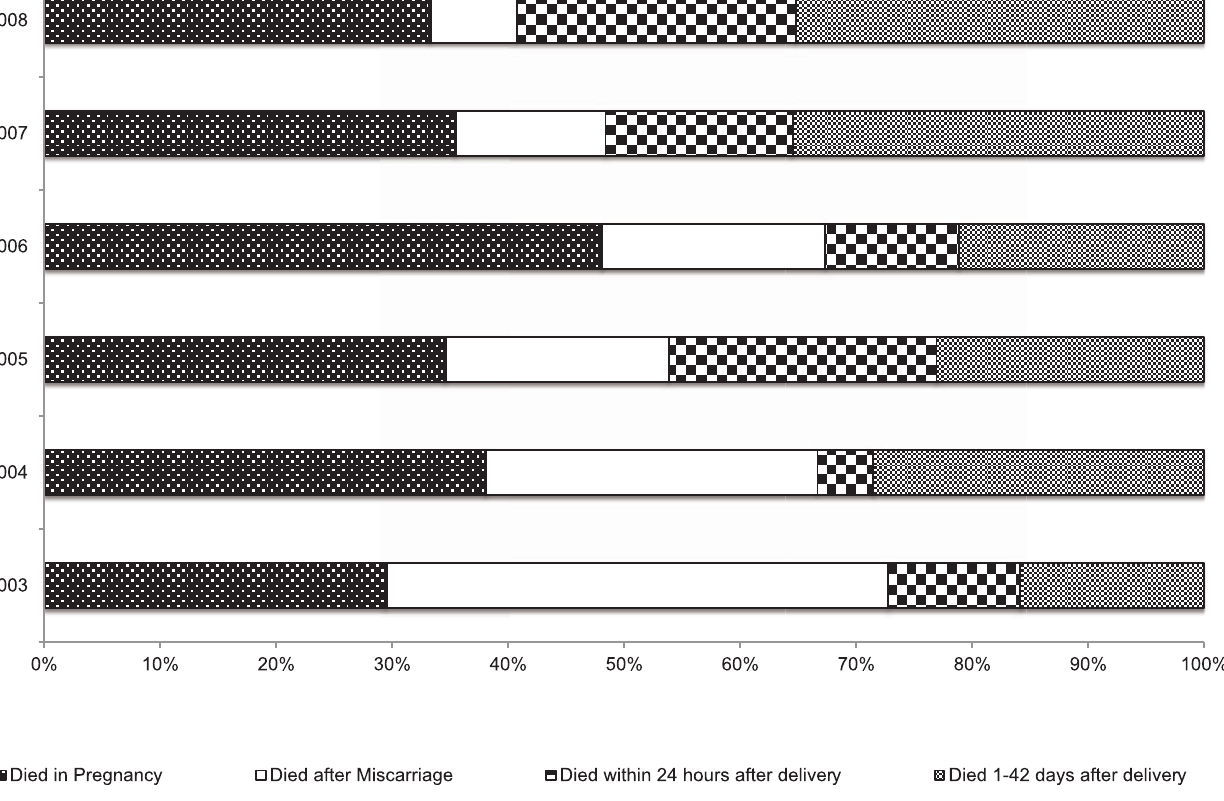
Figure 3. Proportion of pregnancy-related deaths by phase of pregnancy and year of death.* *Note - prior to 2008, VA questionnaire asked for all miscarriages/abortions (spontaneous or induced); as of 2008, the WHO VA questionnaire was adopted which only asked for induced abortions. doi:10.1371/journal.pone.0068733.g003 PLOS ONE |